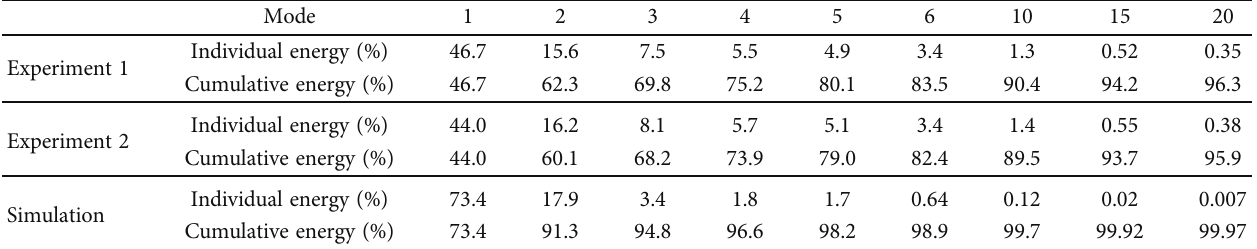
Table 3: Energy proportion of each POD mode for experiment and simulation.